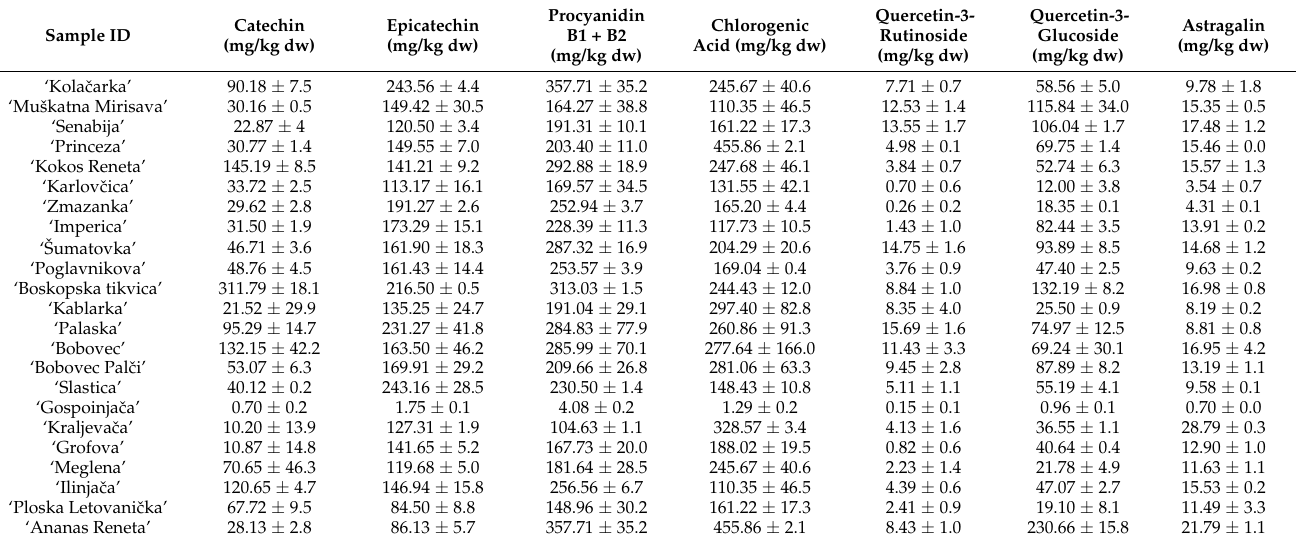
Table 2. Content of polyphenols (mg/kg dw a ) in traditional apple varieties.